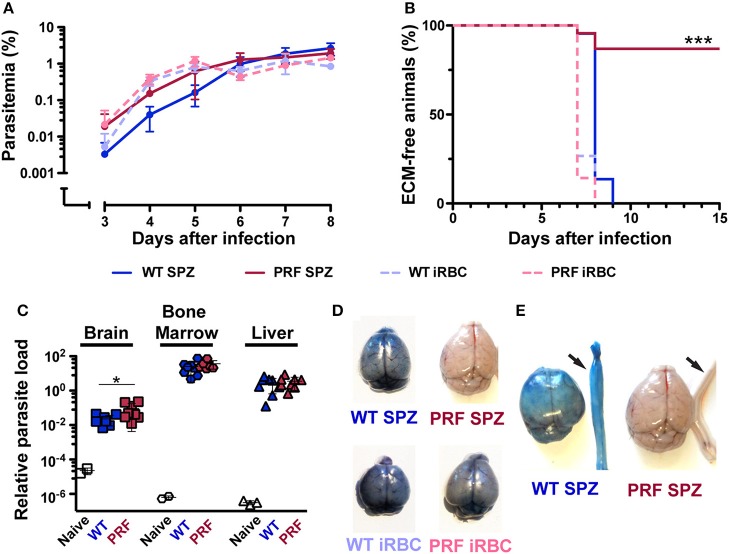
Full virulence after PRF blood infection, but very low ECM pathology after sporozoite infection. (A) Time course of blood infection after sporozoite inoculation or transfusion of iRBCs. C57BL/6 mice were infected by intravenous injection of 5,000 hemocoel sporozoites (solid lines) of either wild type (WT; blue) or PRF (red) parasites (n = 22 each) or 5,000 iRBCs (dashed lines) of WT (blue) or PRF (red) parasites (n = 15 each). Parasitemia was monitored daily by microscopic examination of Giemsa stained blood-films. Differences between asexual blood-stage propagation were non-significant (Mantel-Cox test). (B) Kaplan-Meier analysis of time to development of signature symptoms of experimental cerebral malaria (ECM). ***P < 0.001 (Mantel-Cox test). (C) Quantification of parasite loads in the brain (square), BM (polygon) and liver (triangle) was done by qPCR. Organs were harvested 6 days after infection of C57BL/6 mice with 5,000 WT or PRF sporozoites. Animals were perfused via the left heart ventricle to remove non-sequestering infected red blood cells from the circulation of blood. Relative expression levels of P. berghei 18S rRNA were normalized to mouse GAPDH. Results represent mean values (±SD). *P < 0.05 (Mann-Whitney test). (D) Visualization of integrity of blood-brain barrier in infected mice. Infected mice were intravenously injected with 2% Evans blue dye 8 days after infection by 5,000 WT sporozoites (upper left), PRF sporozoites (upper right), WT- iRBCs (bottom left), and PRF-iRBCs (bottom right). (E) Vascular leakage also occurs in the spinal cords of mice with ECM symptoms. Isolated spinal cords are indicated by arrows and show leakage of the dye in mice with signature ECM symptoms.